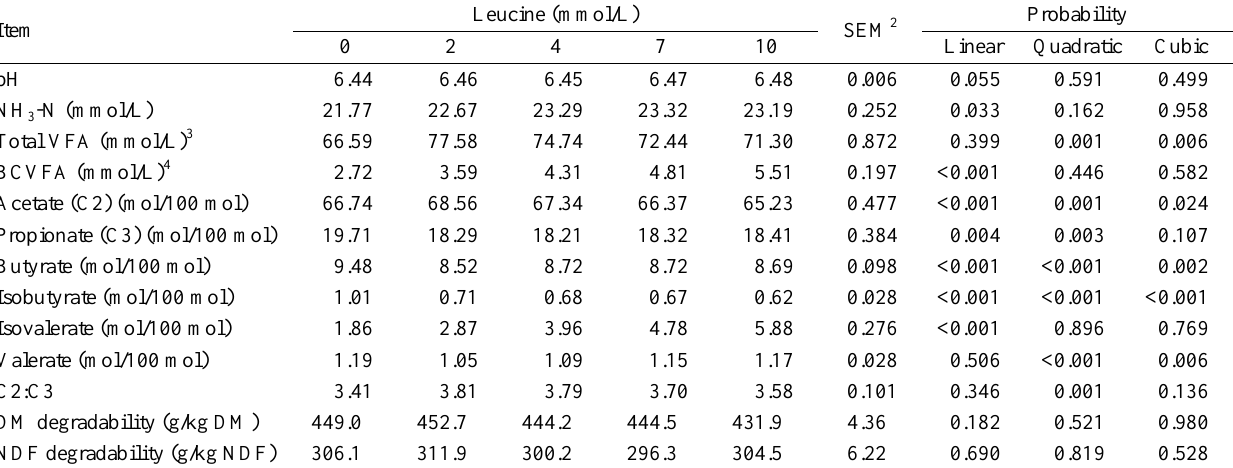
Table 2. Effect of different concentrations of leucine on the ruminal fermentation characteristics, DM and NDF degradability of